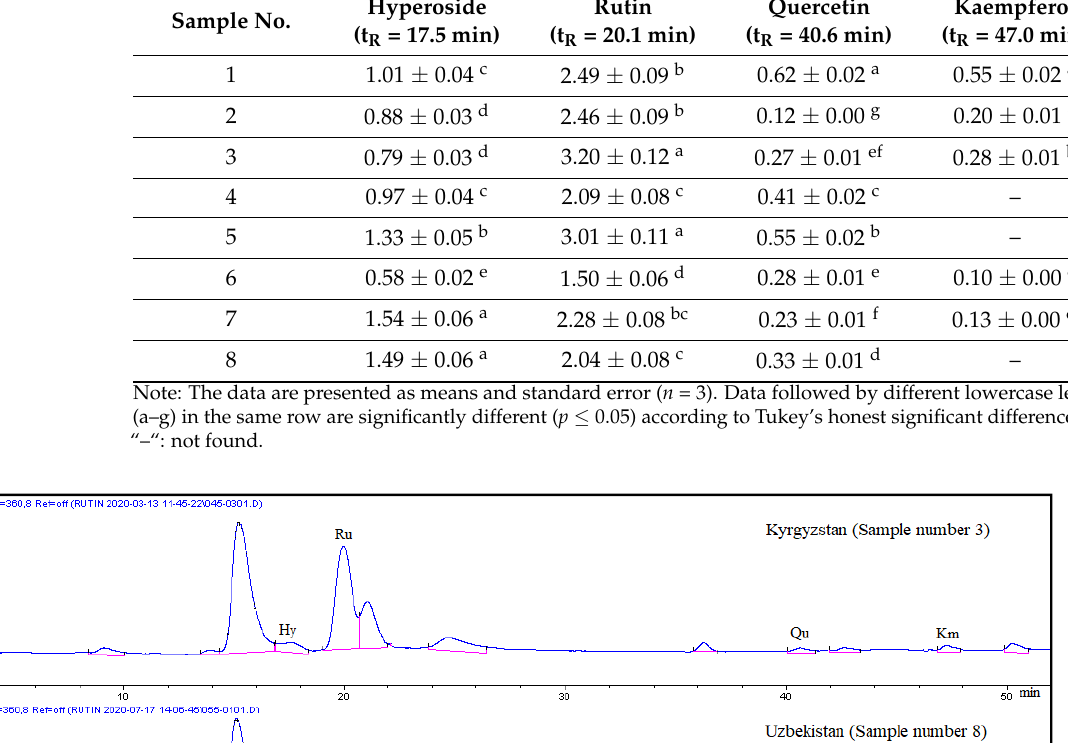
Table 2. Levels of some identified flavonoids in E. longistipitata leaves (mg/g of air-dried matter). Sample No.